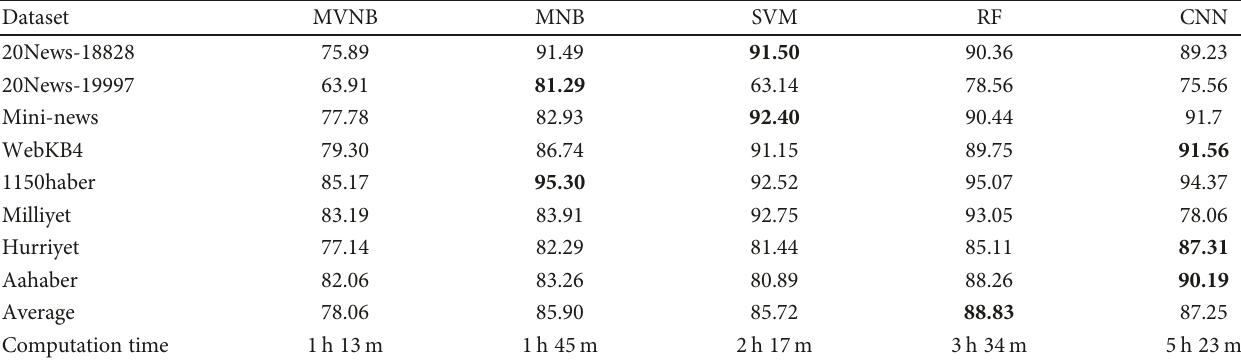
Table 2: Classi fi cation accuracies of single classi fi ers on datasets represented with TF-IDF weighting scheme. Dataset